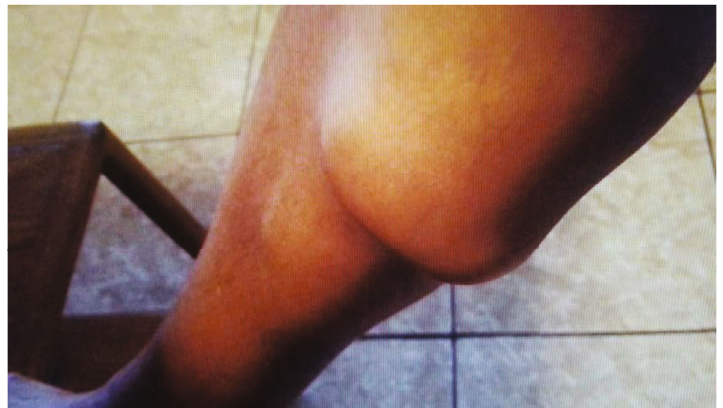
Figure 2: In Trinidad in 2017 before her primary total knee arthroplasty — large collection on the proximal, medial side of her calf distal to the